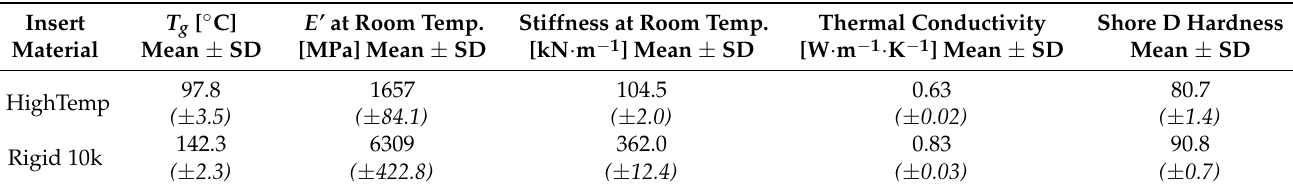
Figure 5. Photographs of the failure modes of the different photoresin mould inserts. HighTemp Table 2. Viscoelastic and physical properties of photopolymer resins used to 3D-print the mould inserts ( left ) presented a trend of breaking in a brittle manner into several pieces, whilst Rigid 10k inserts ( right ) had cracks spanning radially from the ejector pins to the closest edges. inserts and respective standard deviations.